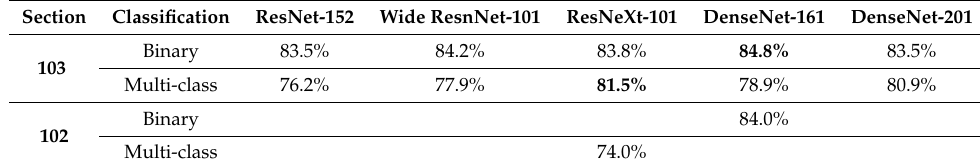
Figure 6. Tornado damage heatmaps from object detection. ( a ) binary inference results, ( b ) binary ground truth, ( c ) multi- class inference results, and ( d ) multi-class ground truth. Table 6. Accuracy of binary and multi-class image